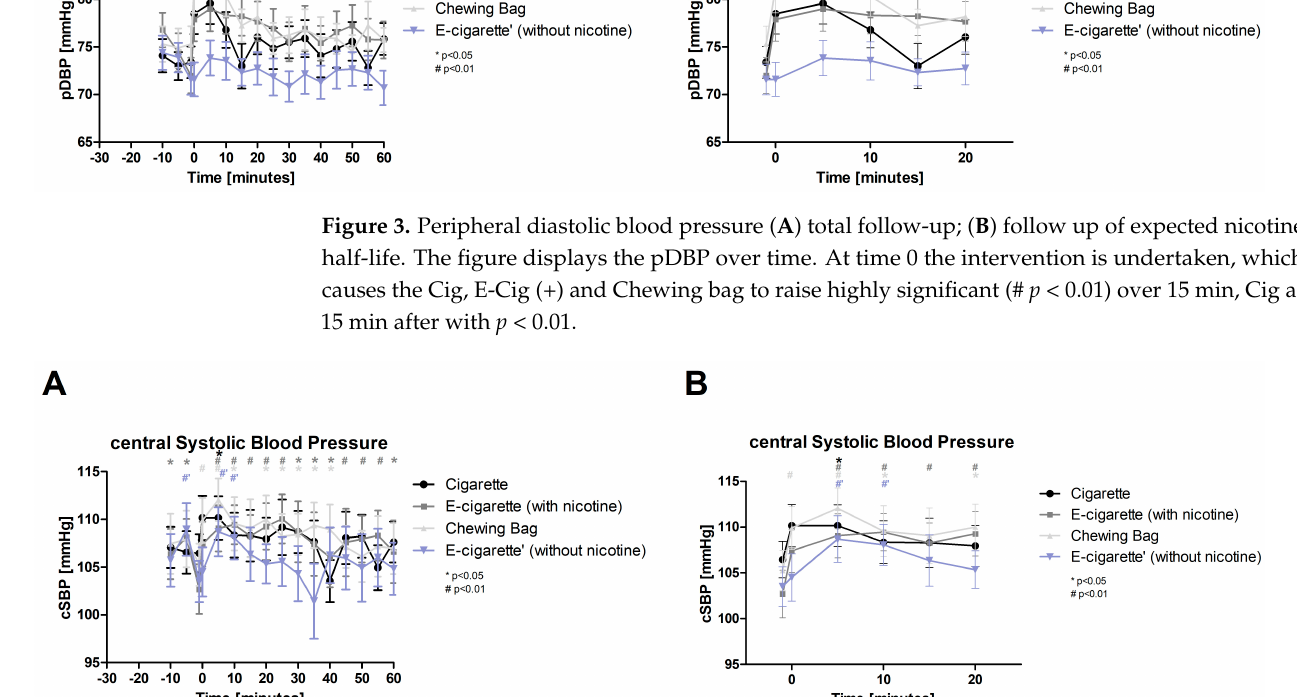
Figure 2. Peripheral systolic blood pressure ( A ) total follow-up; ( B ) follow-up of expected nicotine half-life. The figure displays the change in the pSBP over the time of the testing period. Four groups that are normally distributed show a significant raise at the intervention (time 0) and 5 min after. # displays a p -value of p < 0.01 (highly significant), * a p -value of p < 0.05 (significant). After the intervention, the peripheral diastolic blood pressure (pDBP, Figure 3, normally distributed) significantly increases with a p -value of <0.01 for Cig, E-Cig (+), and Chewing bag instantly and stays elevated for a period of 15 min. The E-Cig (+) stays elevated the longest with 40 min. The E-Cig (+) demonstrates the biggest increase with 9.7% 5 min after the intervention, followed by the Chewing bag with 9.5%. Initially and 5 min after the intervention, the 4 groups showed a significant difference from each other (ANOVA p < 0.05).